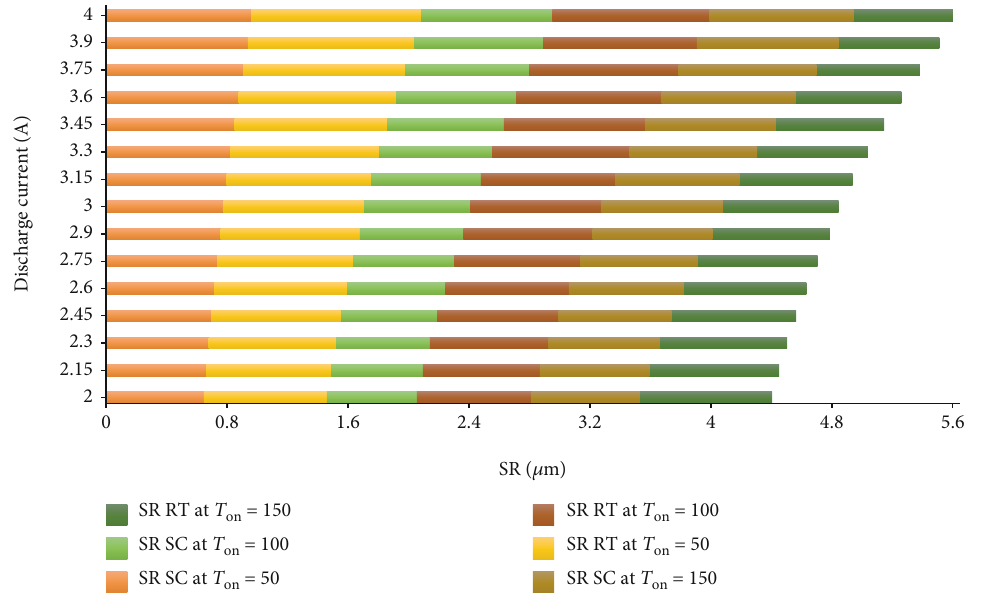
Figure 4: SR vs. discharge current for two types of electrode at τ = 70 % .